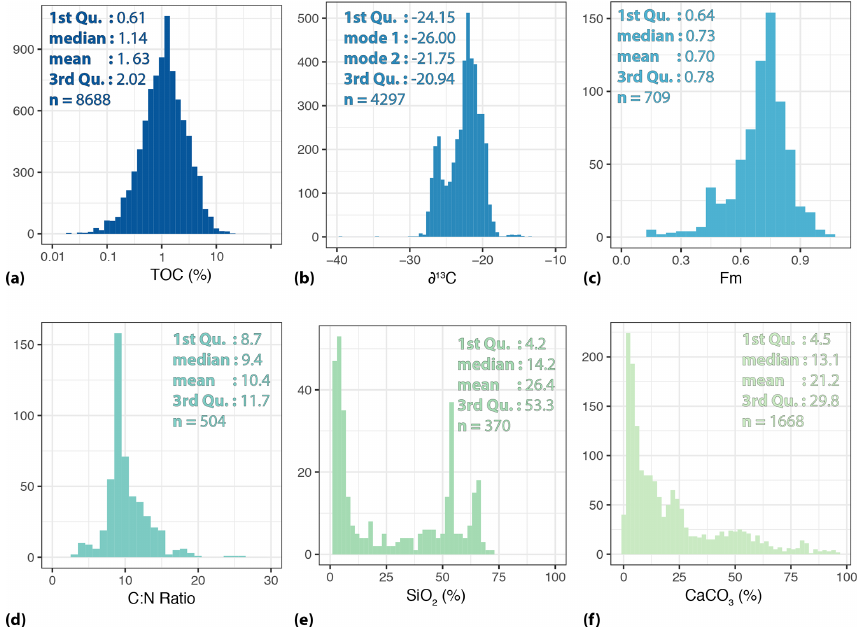
Figure 3. Distribution of data for key sedimentary parameters included in MOSAIC: (a) TOC shows a log-normal distribution which peaks at ∼ 1.1% and averages around 1.6%. (b) δ 13 C values show two distinct peaks (mode 1 and mode 2) at ∼− 26 and ∼ 22‰. (c) Radiocarbon shows a strongly depleted signature with the fraction modern value averaging at ∼ 0.7. The (d) C:N ratio global average is ∼ 10. The median (e) silicate (SiO 2 ) and (f) carbonate (CaCO 3 ) contents are ∼ 14 and ∼ 13%,